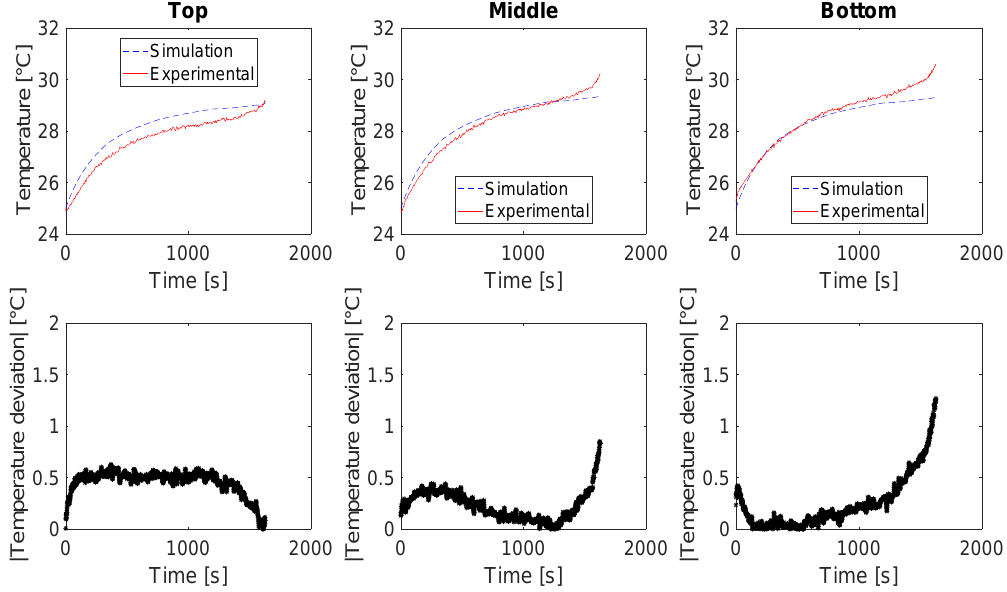
Figure 22. ( Upper ) Cycled cell surface temperature at three different locations (Top, Middle, Bottom) during high constant current discharge at 25 ◦ C room temperature; ( Lower ) Corresponding absolute values of the temperature deviation between experimental and simulations